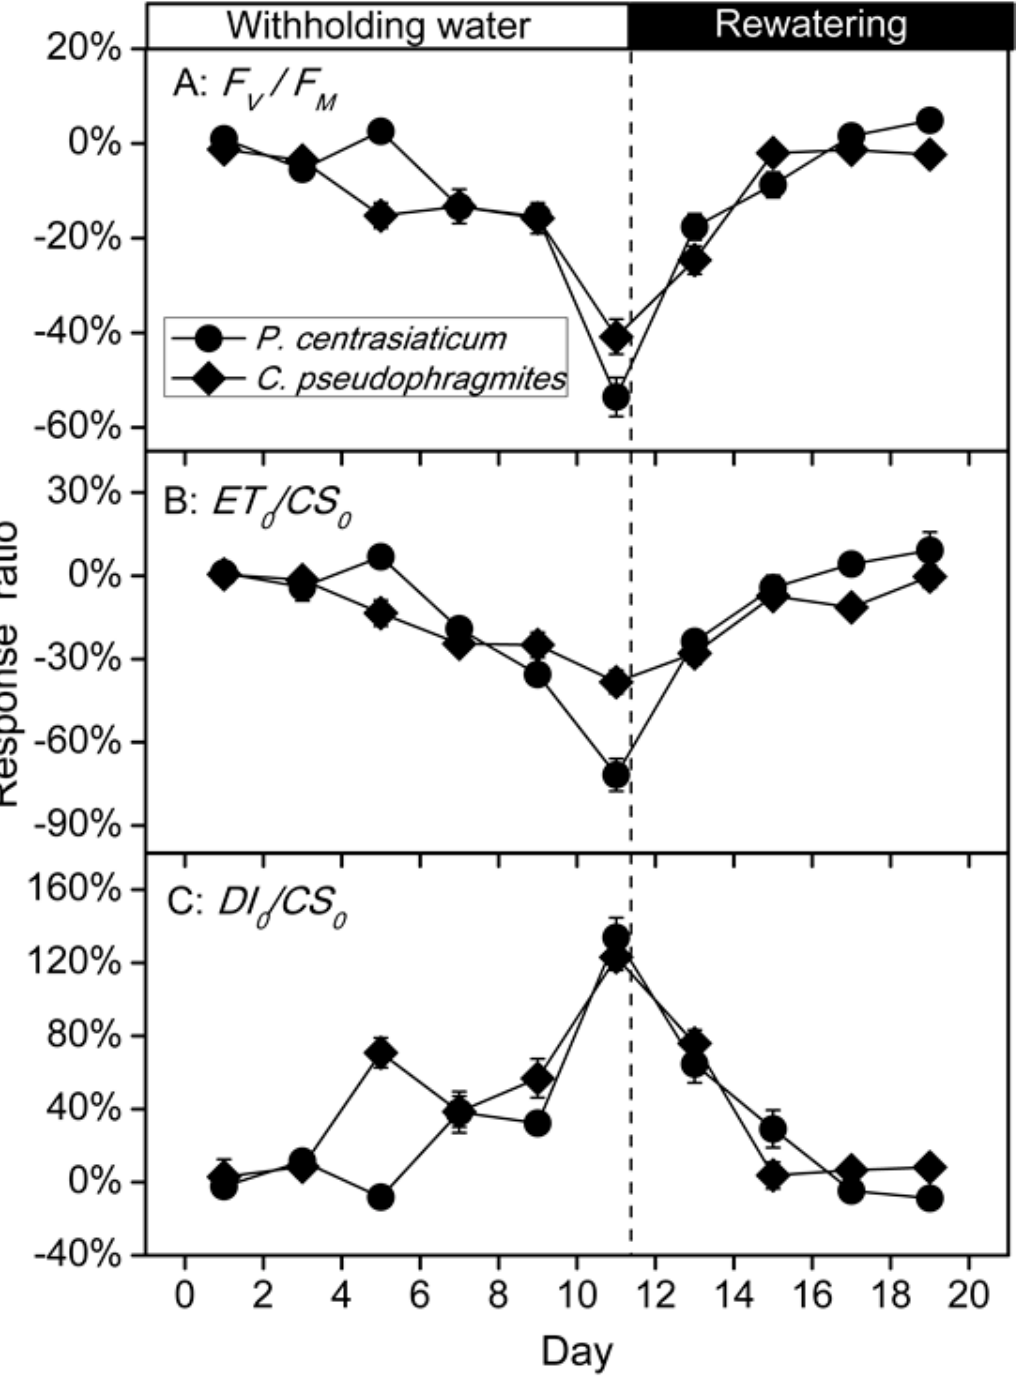
Figure 5. Changes of response ratio in leaf F V / F M (maximum quantum yield of PS II), ET 0 / CS 0 (electron transport flux) and DI 0 / CS 0 (dissipated energy flux) during drought and rewatering period for P. centrasiaticum (C 4 ) and C. pseudophragmites (C 3 ), respectively. Filled circles ( ● ) and diamond ( ♦ ) denote P. centrasiaticum and C. pseudophragmites respectively. The beginning of rewatering is indicated by the dotted line.